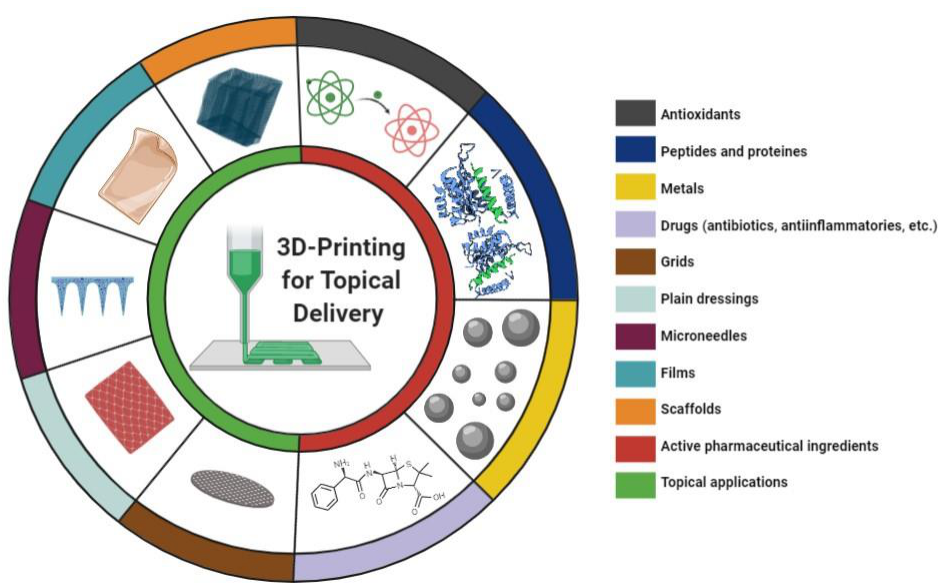
Figure 5. 3D printed products (left side of the circle) and types of active ingredients (right side of the circle) previously proposed for topical skin applications.